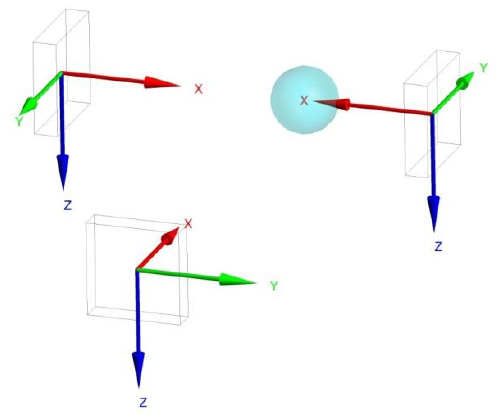
Figure 7. Selection of coordinate systems for bending moment evaluation.